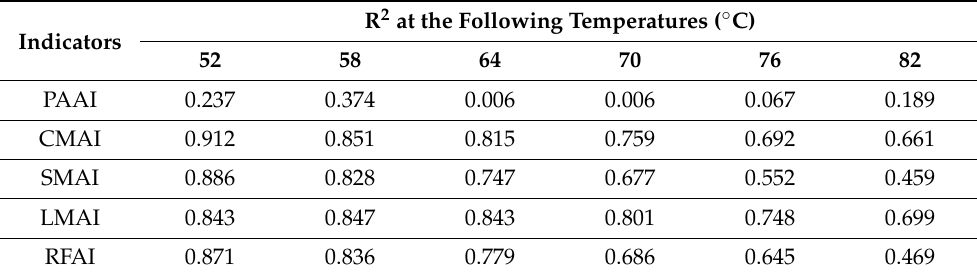
Table 5. The correlation coefficients between CAI and other aging indicators. R 2 at the Following Temperatures ( ◦ Indicators